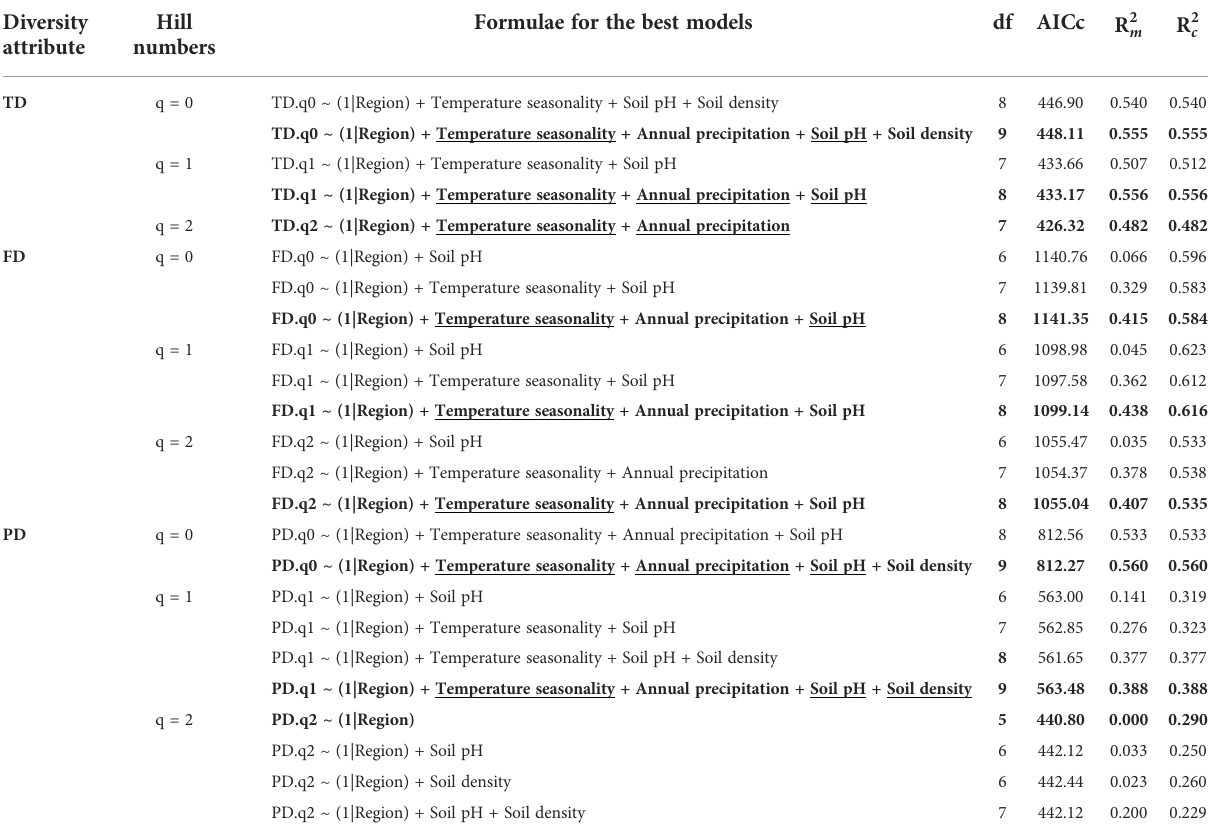
TABLE 3 Comparison of the best alternative models for Hill numbers of taxonomic diversity (TD), functional diversity (FD), and phylogenetic diversity (PD) as functions of temperature seasonality, annual precipitation, soil pH, and soil bulk density. Diversity attribute